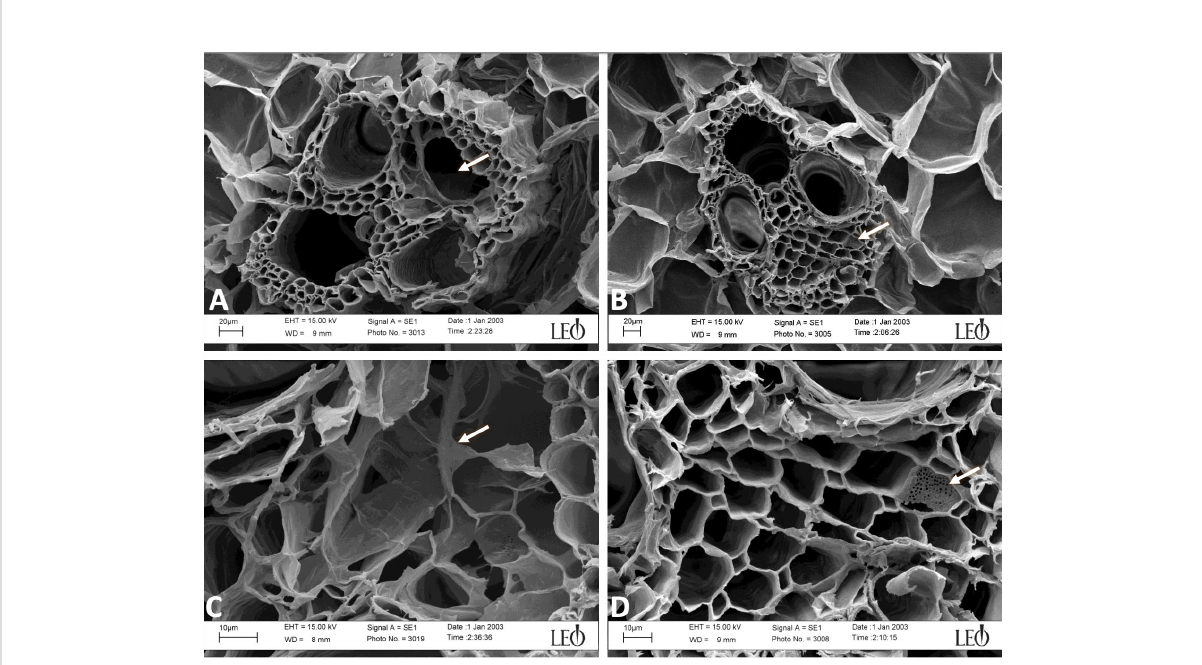
FIGURE 7 Magni fi ed views of vascular bundles by scanning electron microscopy (SEM) of corn stem cross sections after being in culture with S. obliquus (A, C) or incubated with just BG-11 media (B, D) . Arrow in (A) points to the phloem area where the phloem cells are almost entirely degraded. Arrow in (C) shows digested cell walls of phloem. Arrows in (B, C) point to the same sieve